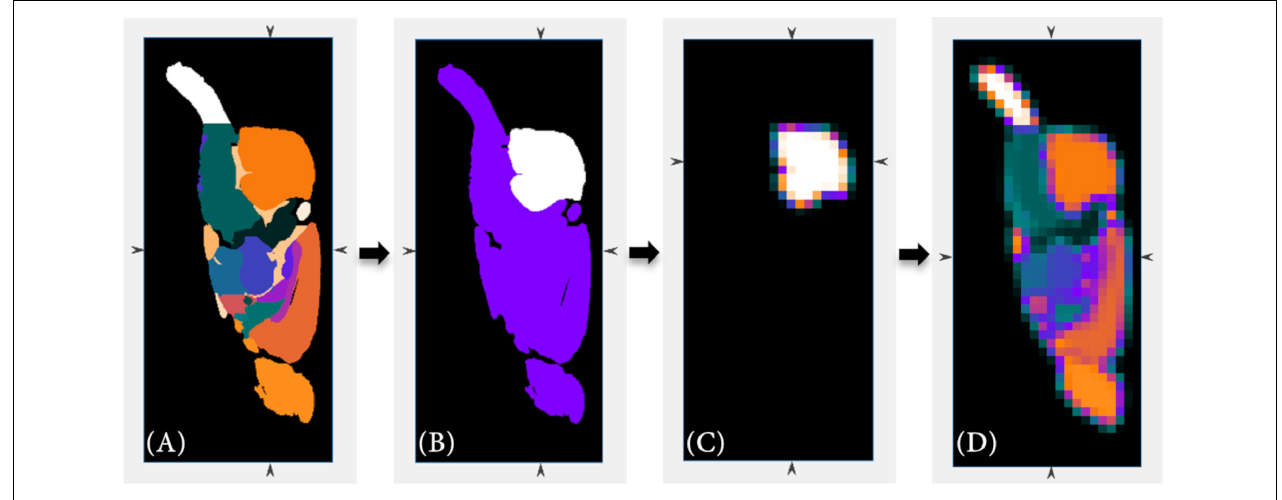
FIGURE 2 | The high-resolution anatomical atlas (A) is resized to the lower resolution of the PET data (D) using Matlab’s imresize3.m function. Beside the full volume, the individual sub-regions of the anatomical atlas (B) are also resized (C) in order to allow a more detailed sub-classification (cerebellum region as example).